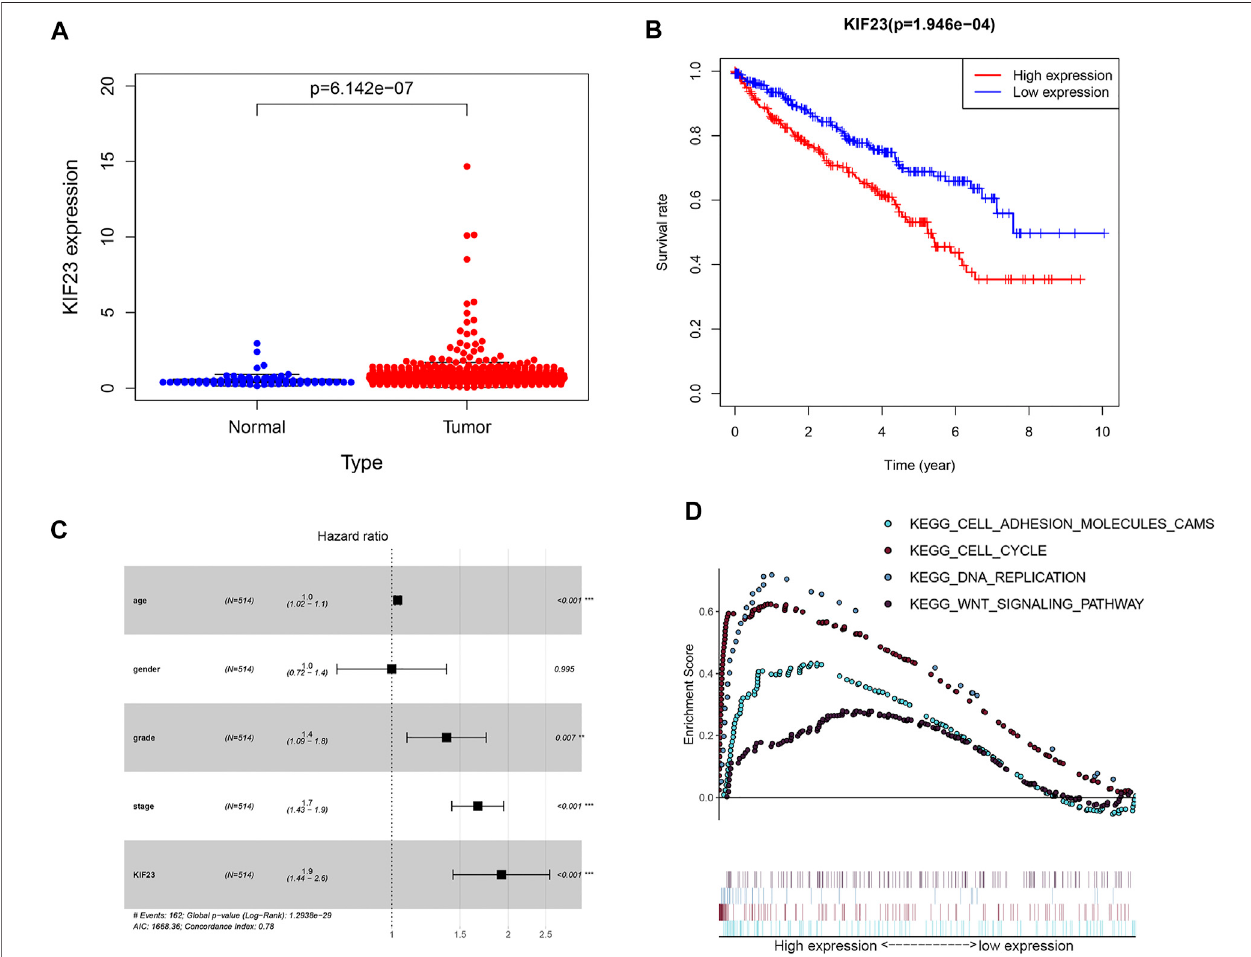
FIGURE 7 | The expression data of KIF23 in ccRCC from TCGA database. (A) Human KIF23 expression levels in normal and ccRCC tissues from the TCGA database. (B) Kaplan-Meier plotters of KIF23 in ccRCC. (C) Multivariate Cox hazards regression analyses. (D) GSEA analysis.